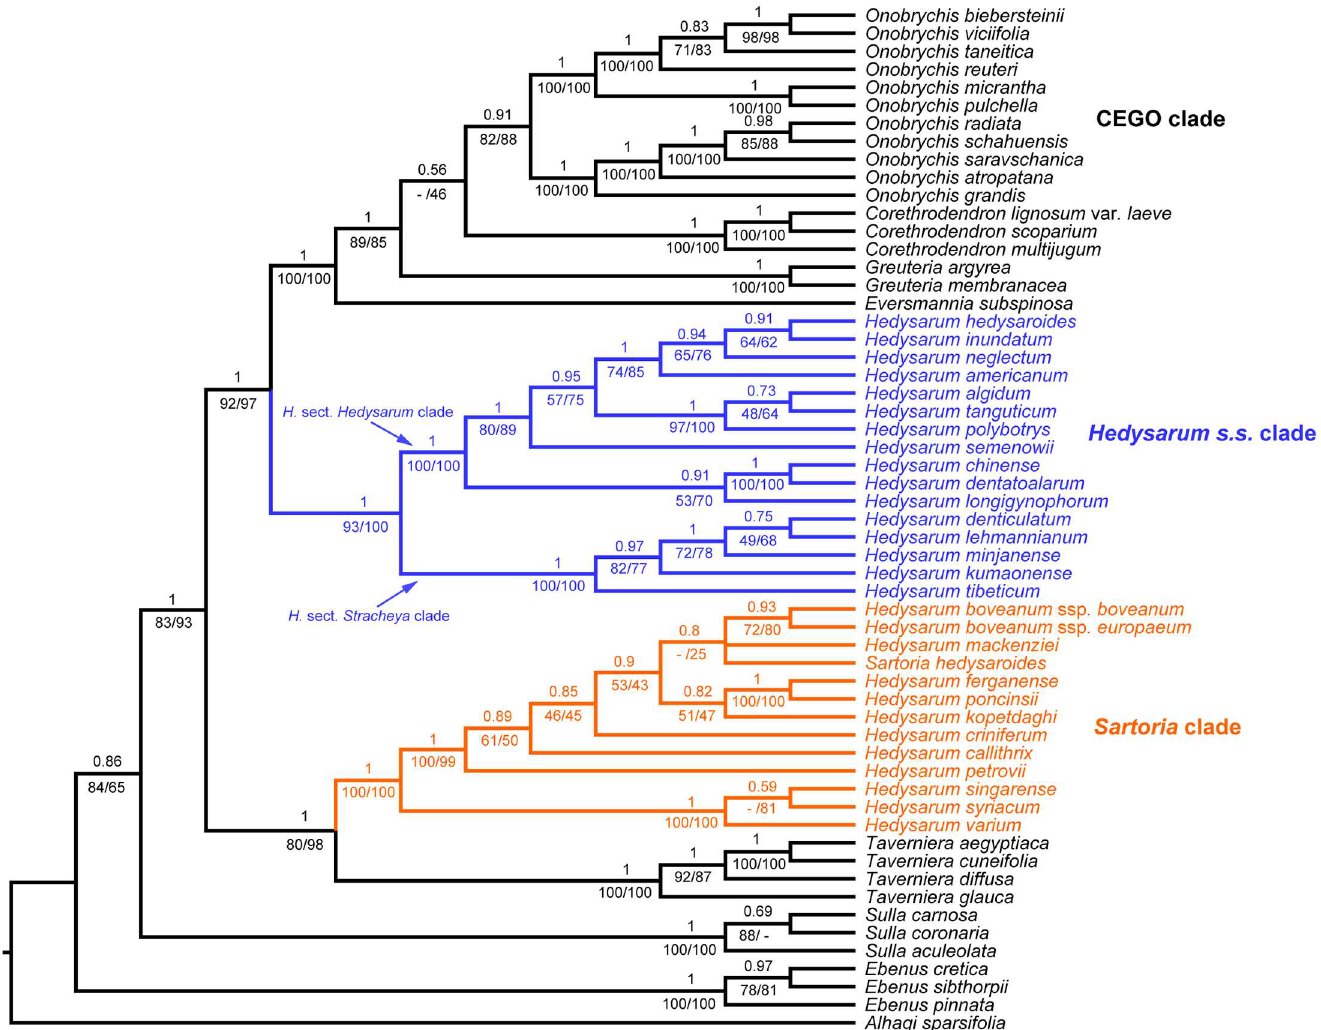
Fig 1. Bayesiantree based on the concatenated nuclear ITS, ETS, PGDH , TRPT and SQD1 sequences. The Bayesianposterior probabilities are abovethe branches, and the maximum parsimony (left) and maximum likelihood(right) bootstrap support values are below the branches. Dashesindicate branches that are not found in the maximum parsimonytree or the maximum